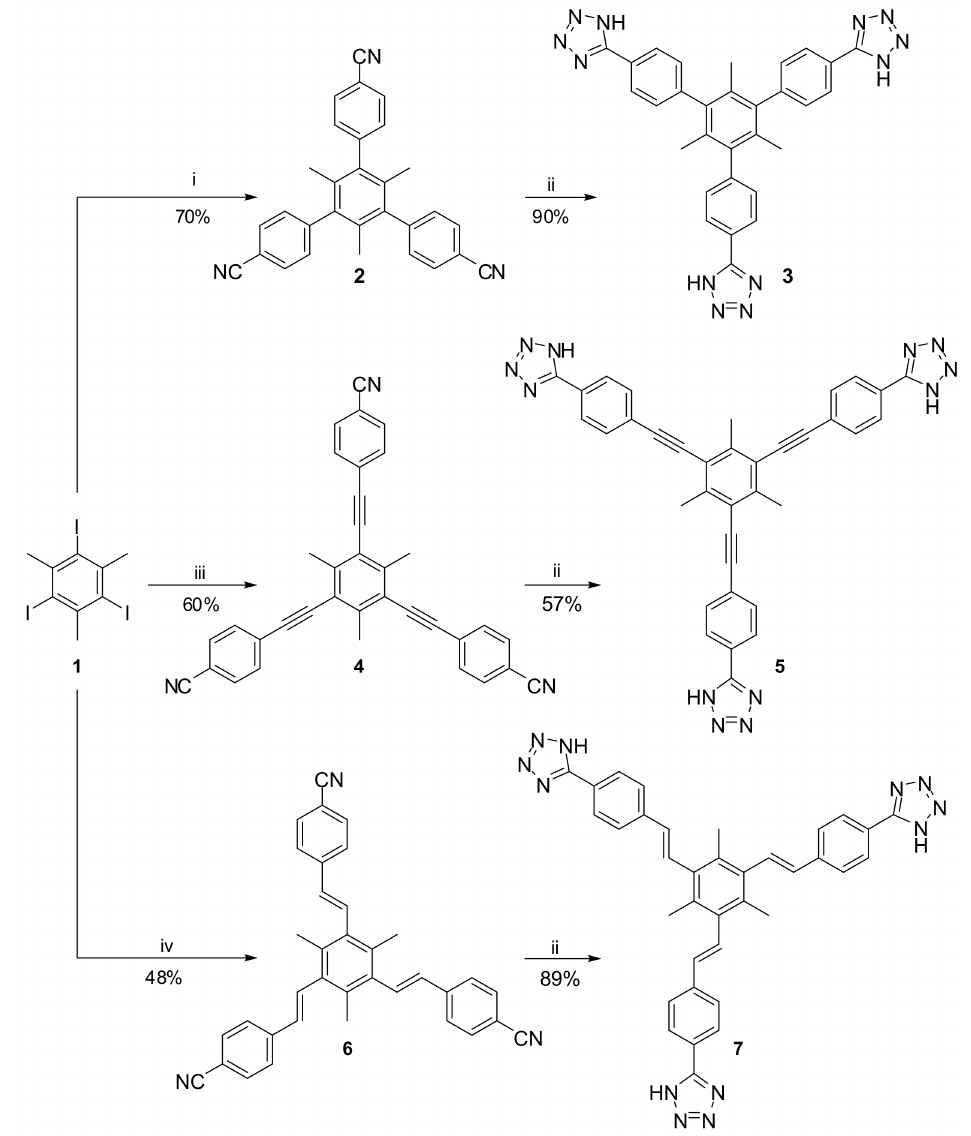
Scheme 1. The synthesis of tetrazolyl linkers 3 , 5 and 7 . Reaction conditions are as follows: ( i ) 4-cyanophenylboronic acid, K 2 CO 3 , PhCH 3 /EtOH/H 2 O, XPhosPd G4, 100 ◦ C, 6 h; ( ii ) NaN 3 , triethylamine hydrochloride, 120 ◦ C, 24 h; ( iii ) 4-ethynylbenzonitrile, TEA, XPhosPd G4, 55 ◦ C, 72 h; ( iv ) 4-cyanostyrene, K 2 CO 3 , 1,4-dioxane/H 2 O, XPhosPd G4, 110 ◦ C, 40